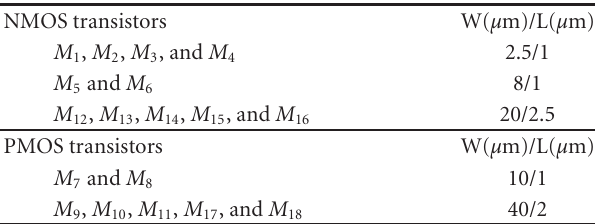
Table 2: Dimensions of the MOS transistors of the circuit of Figure